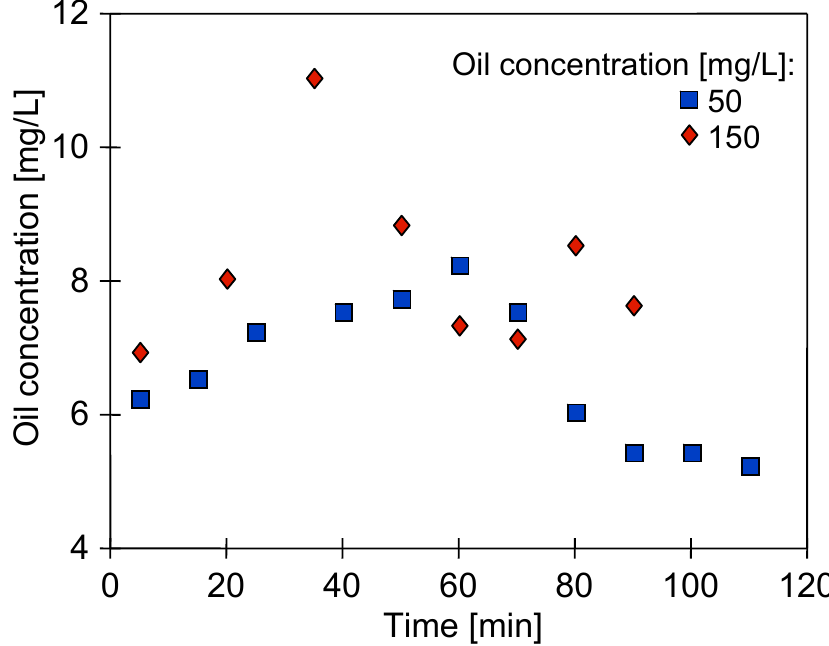
Figure 6. Changes in the oil concentration in permeate during MF of model oily emulsions. Module MF1, V F = 0.5 m/s, TMP = 0.05 MPa, T = 22 ◦